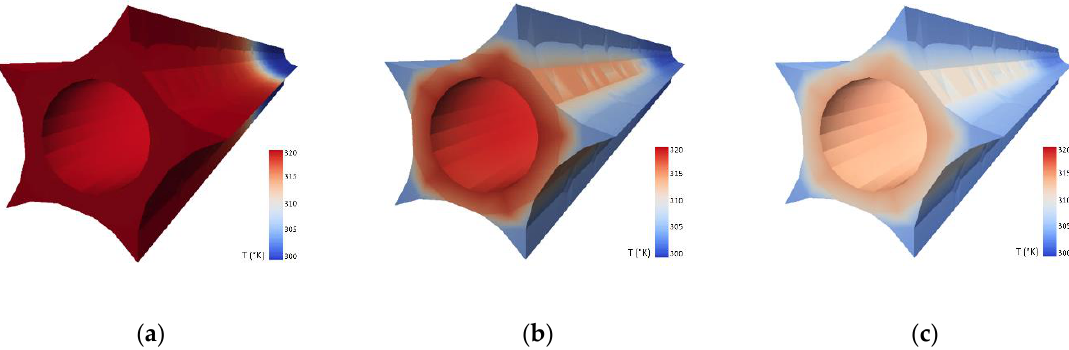
Figure 14. Example results of FE simulations presenting the temperature field along the sensor during equalization process after: ( a ) 0; ( b ) 10; ( c ) 30 sec. of liquid circulating (the TCS tubes were removed to keep the appropriate clarity).